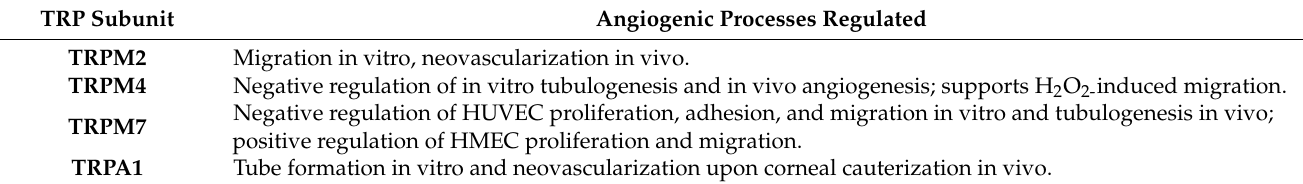
Table 3. Angiogenic processes regulated by TRPM subunits and